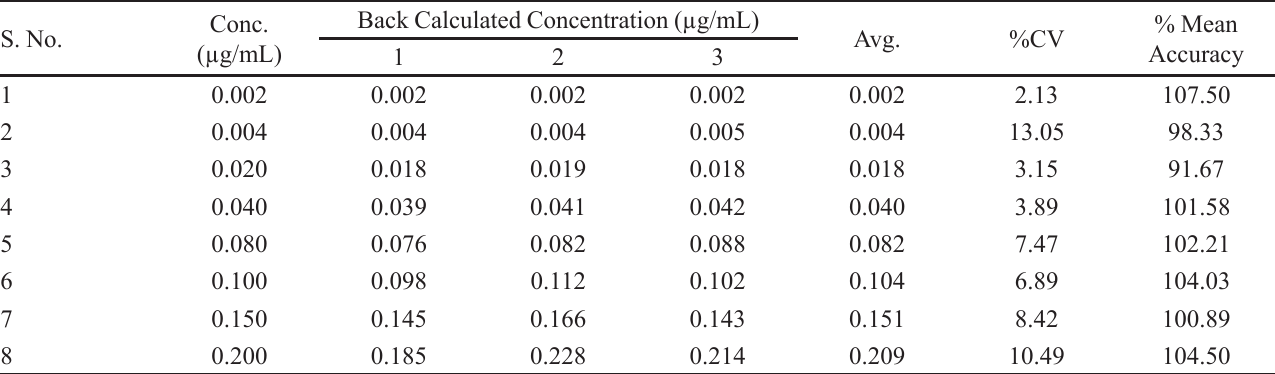
TABLE VI - Linearity S.